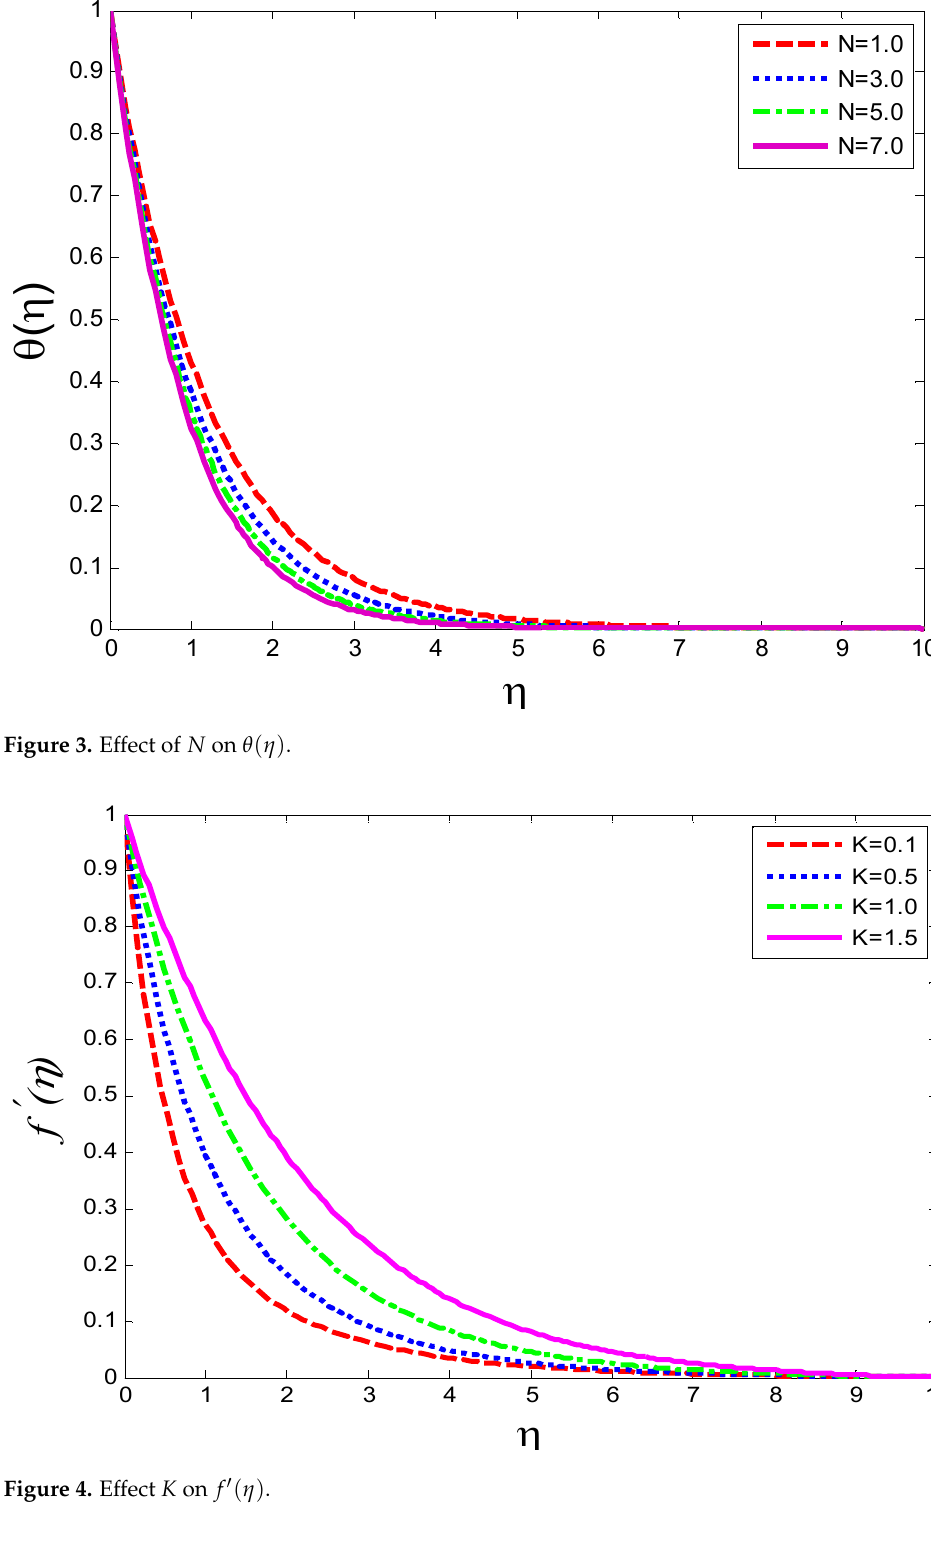
Figure 5. Effect of 𝐾 on 𝜙 .